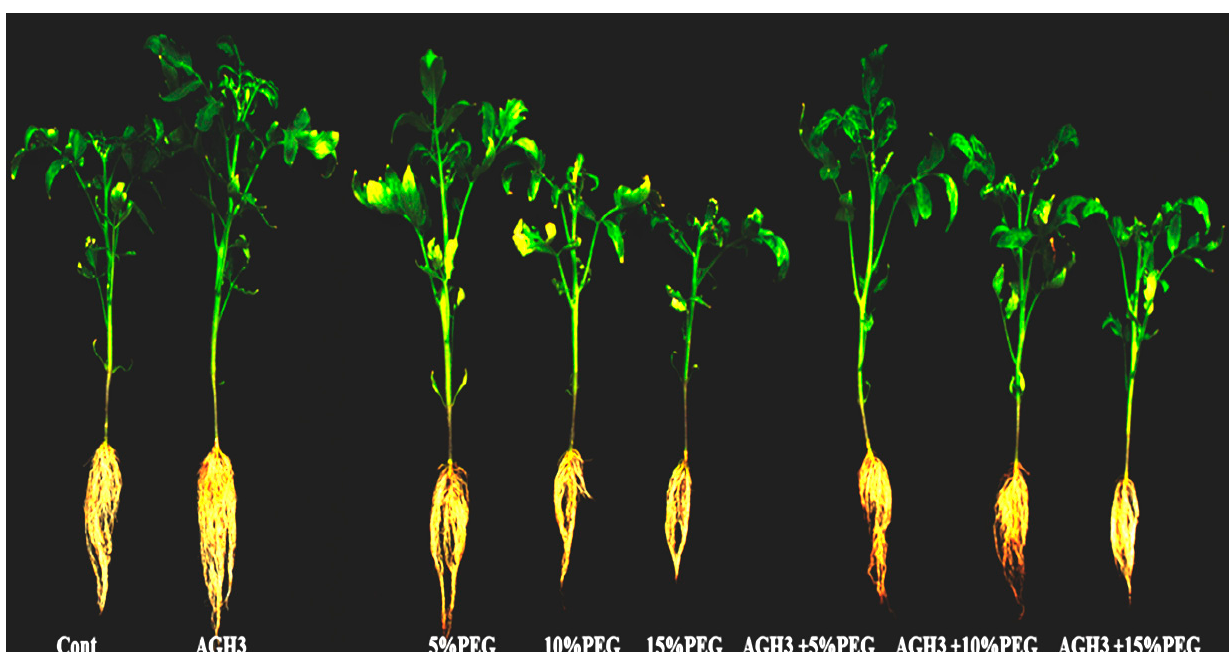
Figure 3. Effect of AGH3 on S. lycopersicum under normal and stressful